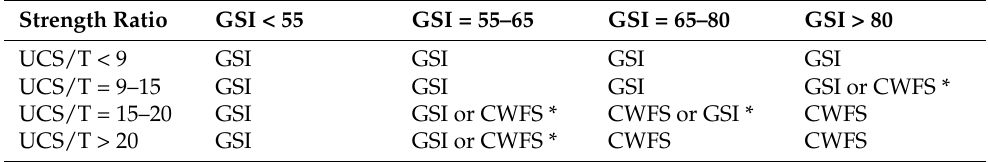
Table 1. Constitutive model selection based on rock strength and GSI, modified from [8]. Note that UCS and T indicate intact unconfined compressive strength and tensile strength,